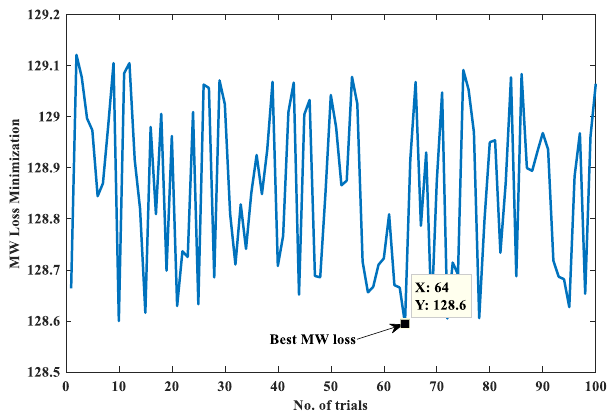
Figure 8. Pareto optimal front for the IEEE 118 test system.